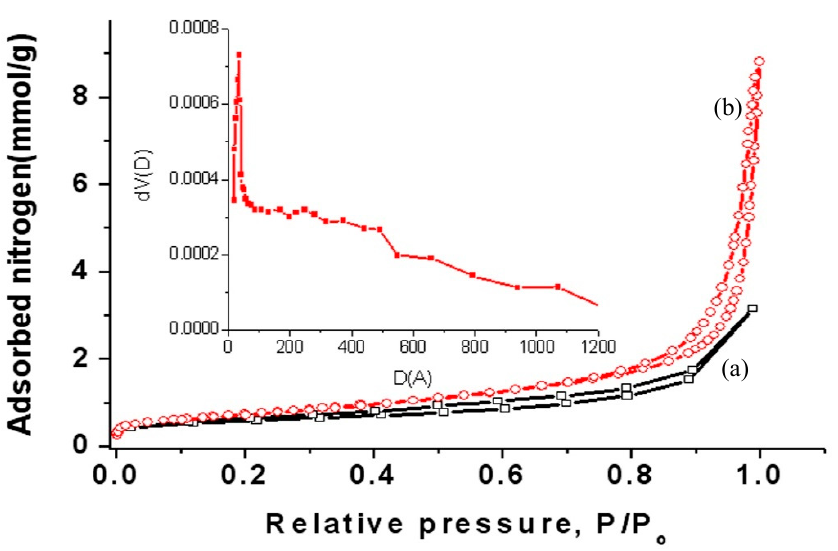
Figure 8. Nitrogen adsorption-desorption isotherm of: ( a ) Zn-Al LDH and ( b ) Zn-Al-GO1 (Inset-Pore size distribution of Zn-Al-GO1).